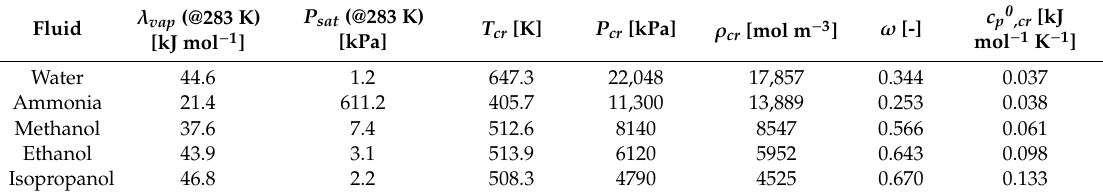
Table 1. Physical and Critical Properties of Common